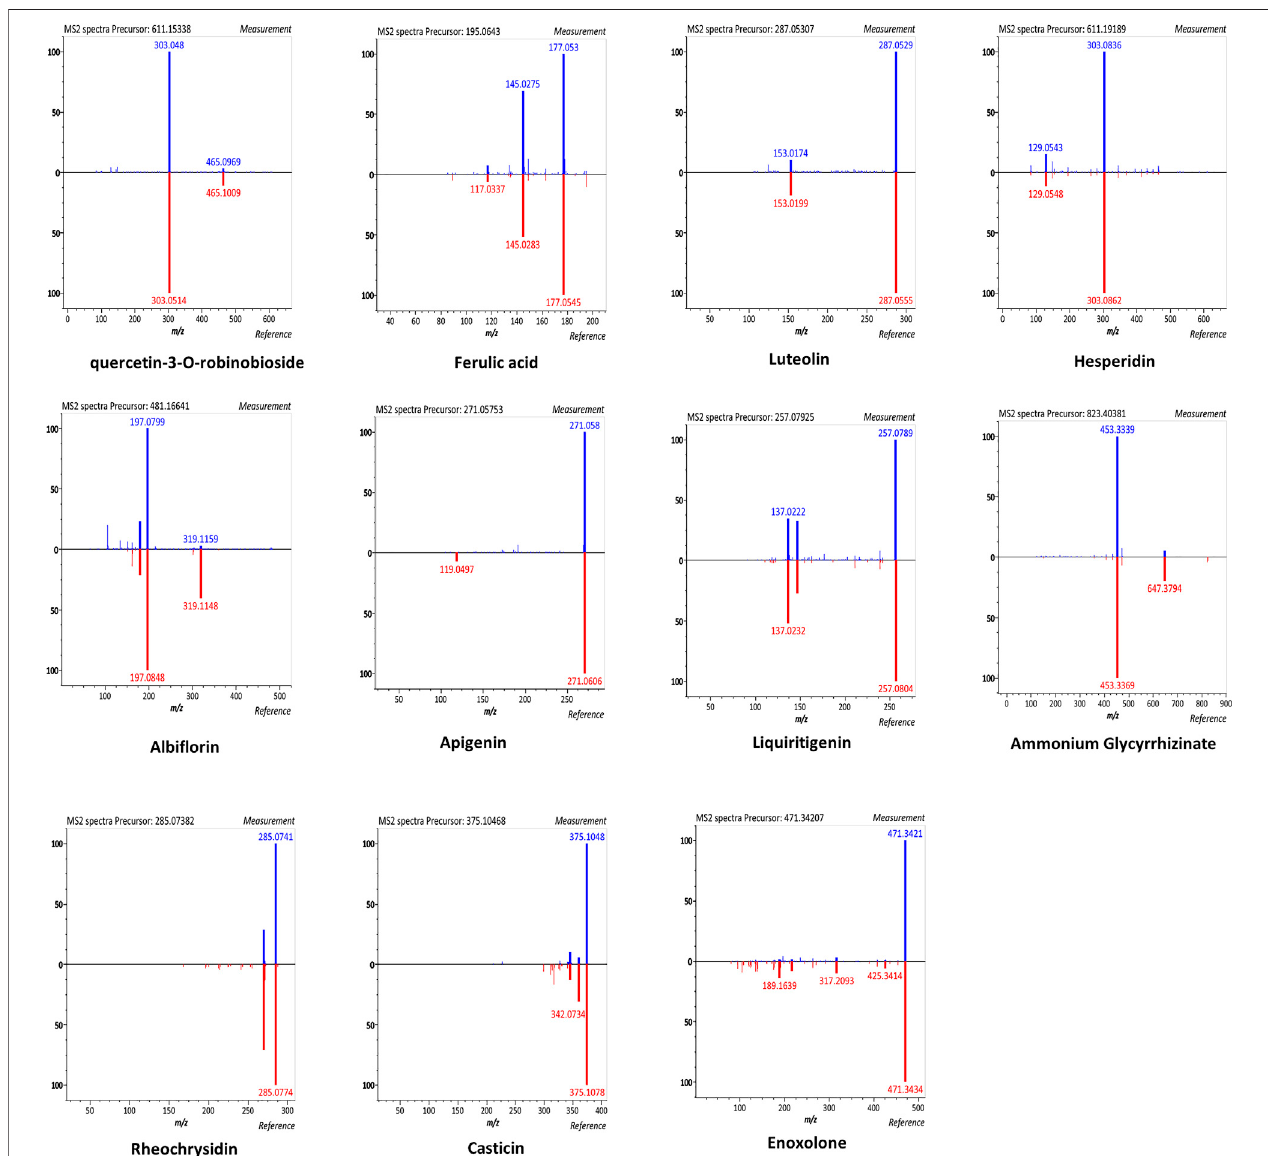
FIGURE 2 | The mirror plots of secondary metabolites in SHCGT. The mirror plots that illustrate MS/MS spectral match of measured peaks of secondary metabolites in SHCGT and reference peaks for authentic standard compounds.